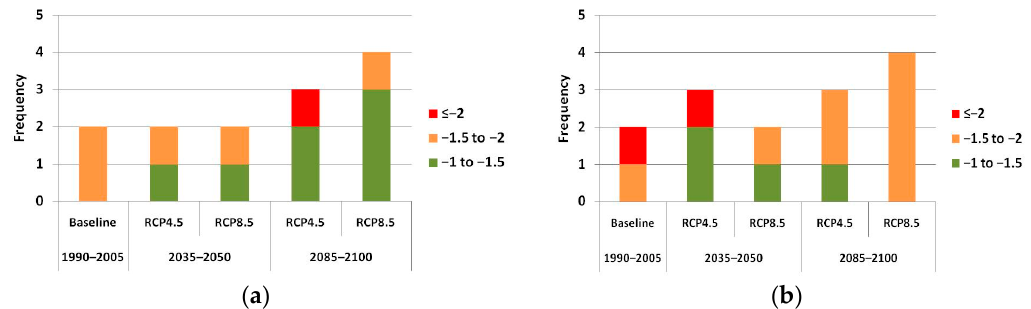
Figure 11. Distribution of dry years by severity classes according to ( a ) SPI-12 and ( b ) SDI-12.